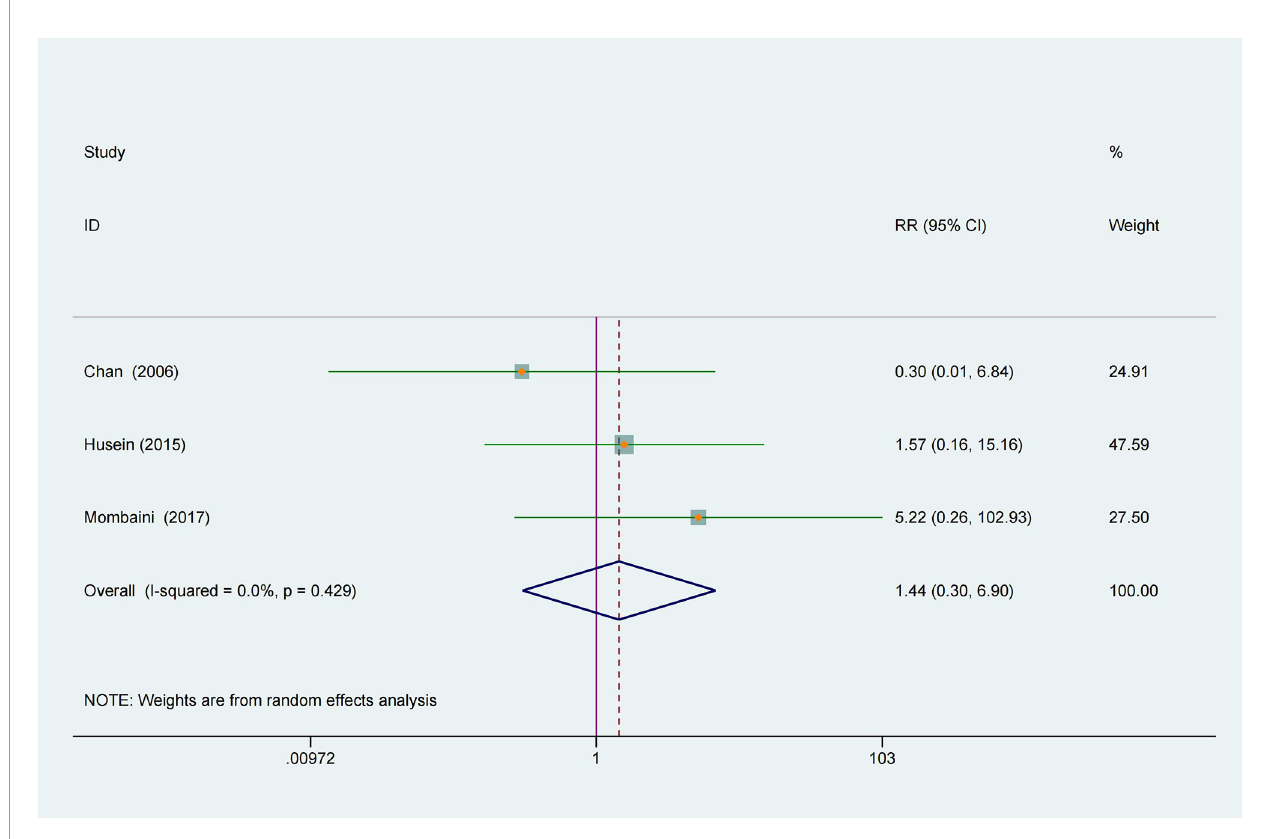
FIGURE 6 | Effect of tea supplements on the risk of adverse